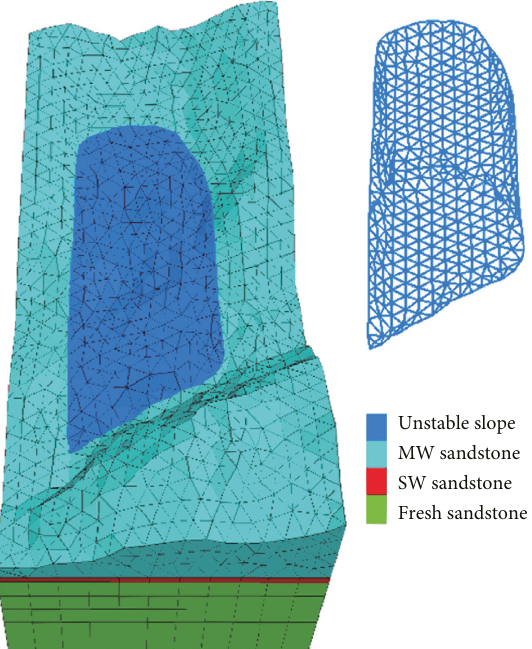
Figure 5: Numerical grid of the slope and the interface.